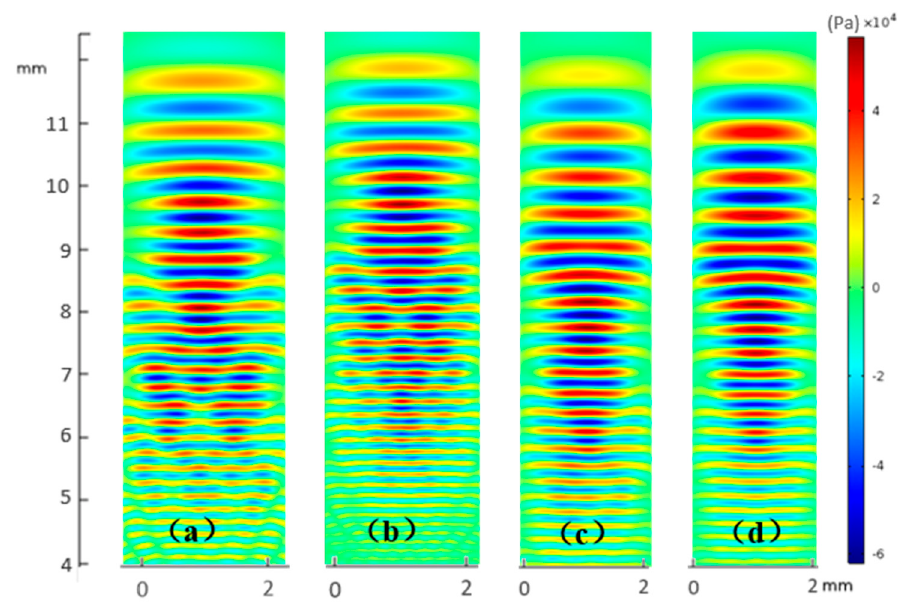
Figure 6. Sound field of transducers with different non-uniformities at the same time. ( a ) A uniform linear array transducer, ( b ) a linear array with various kerfs, ( c ) a linear array with various widths, and ( d ) a linear array with various widths and kerfs.